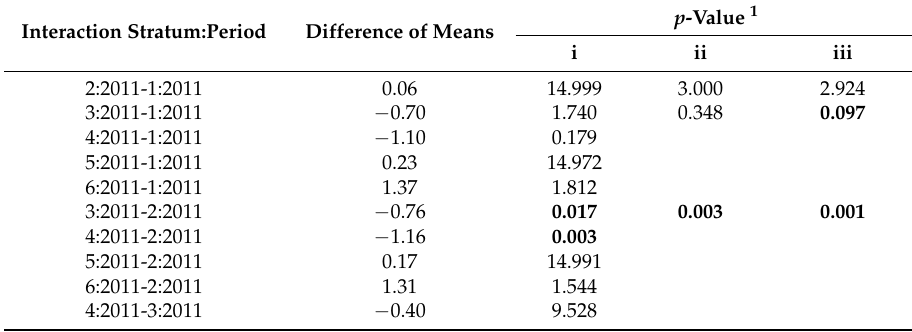
Table A2. Tukey’s Test. Variable: Consumption per